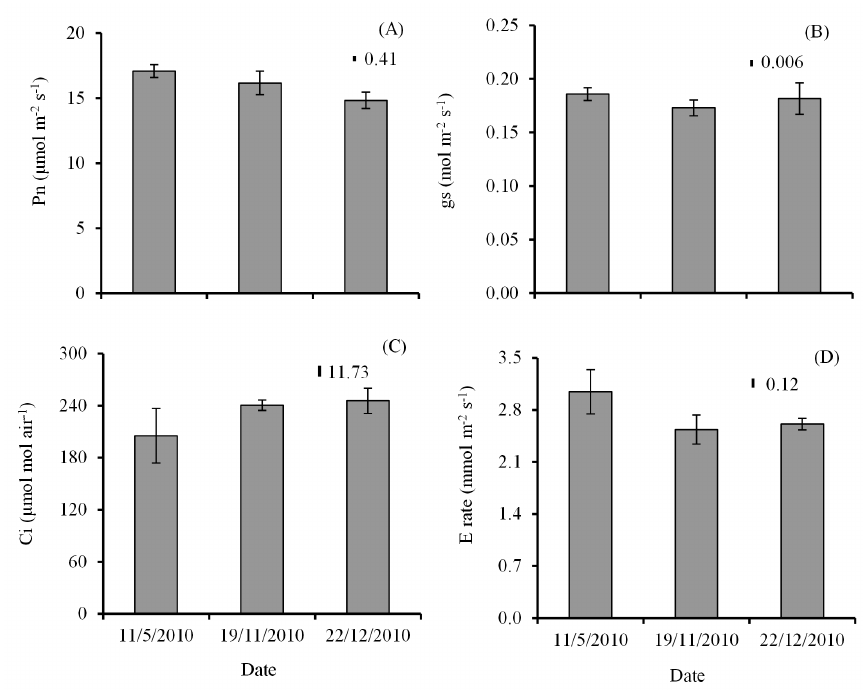
Fig. 1: Net photosynthesis (Pn), stomatal conductance (g s ), intracellular CO 2 concentration (Ci) and transpiration rate (E rate) in response to seasonal de- velopment in Koroneiki leaves, in 2010. A, Pn; B, g s ; C, Ci; D, E rate. Bars without numbers correspond to standard deviations; bars with numbers to Standard Errors from the residual variance (ANOVA) of three replicates, d.f. = 6. In A, P < 0.05, whereas in B, C and D, P > 0.05 in all of